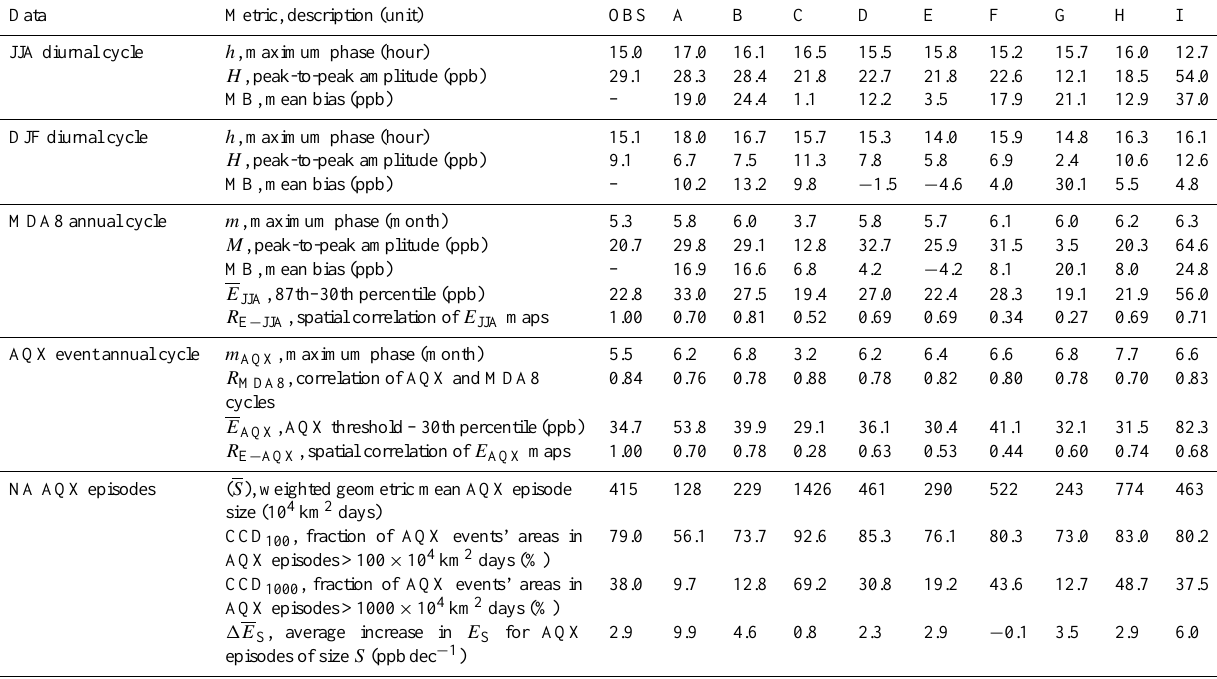
Table 3. Example summary statistics for the observations (OBS), the ACCMIP models (A–H), and the UCI CTM (I) for eastern North American (ENA) summer (JJA) and winter (DJF) diurnal cycles, annual cycle of MDA8, annual cycle of AQX events, and North American (NA, combined western North America (WNA) and ENA) AQX episodes (100 AQX events per decade case).